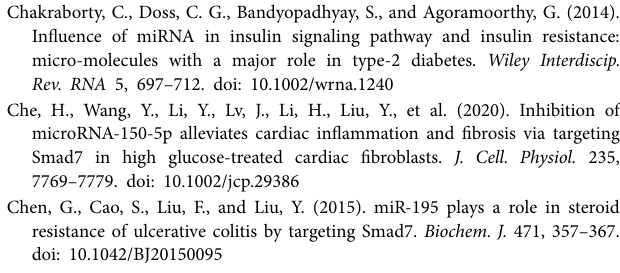
Supplementary Figure 1 | Rat modeling process. Supplementary Figure 2 | Cell treatment